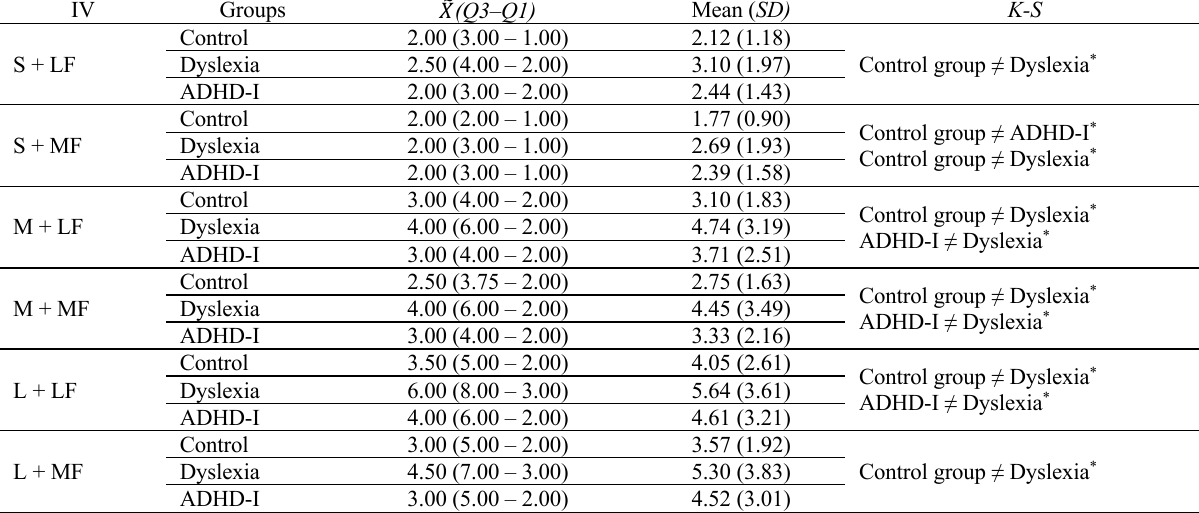
Table 5 – Median, 1 st and 3 rd percentiles, mean, standard deviation, and multiple comparison test: First Fixation Count as a Function of Word Frequency and Word Length interaction in Dyslexia, Control and ADHD-I